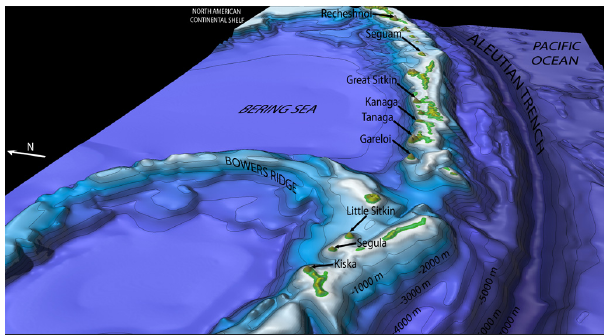
Fig. 1. Location of Aleutian Ridge with respect to the Aleutian arc. Most of the volcanoes in the list have erupted in the last 200 years.